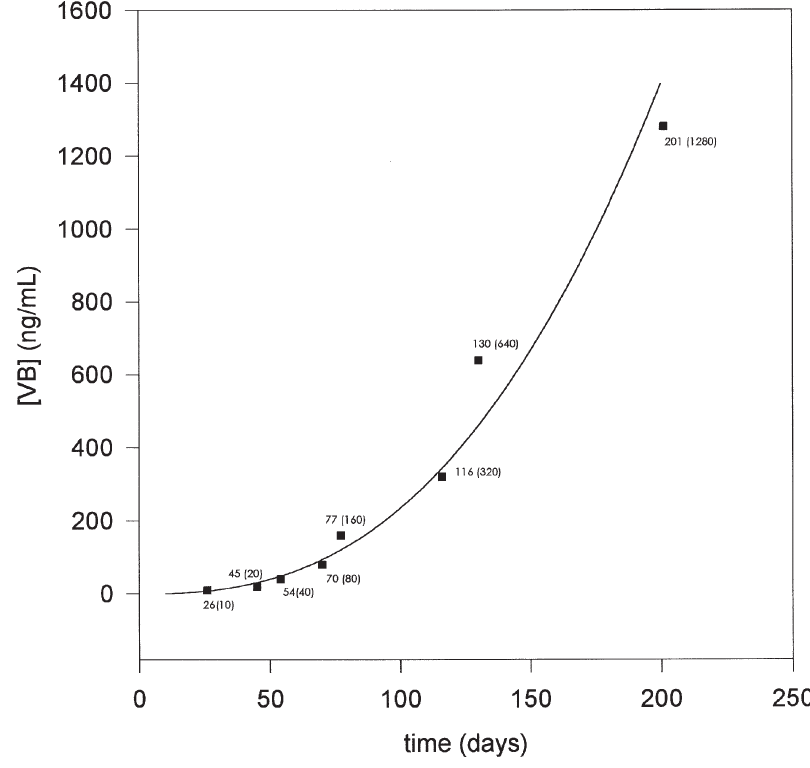
Fig. 1. Graph showing the selection procedure of CHO-K1 cells in phases of increased drug concentration from 10 to 1280 ng/ml of vinblastine. Each square represents the day of culture confluence or establishment of resistance, in days (numbers out of parenthesis), as a function of drug concentration (numbers in